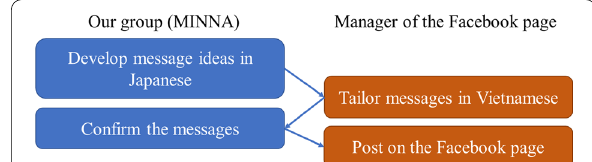
Fig. 2 Flow of developing Vietnamese messages on